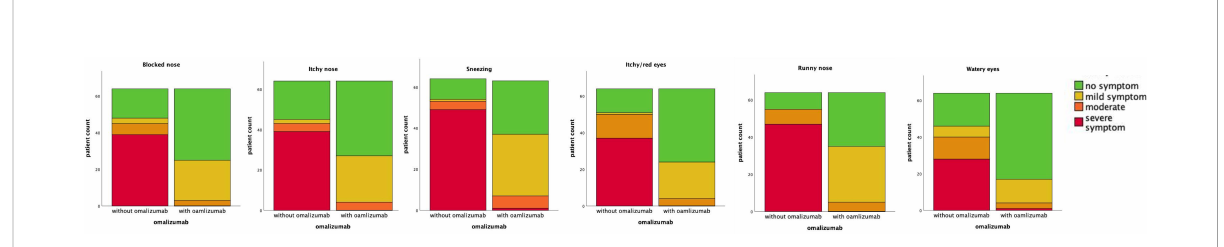
FIGURE 1 Preventative omalizumab treatment could improve clinical symptom of SARC patients signi fi cantly.